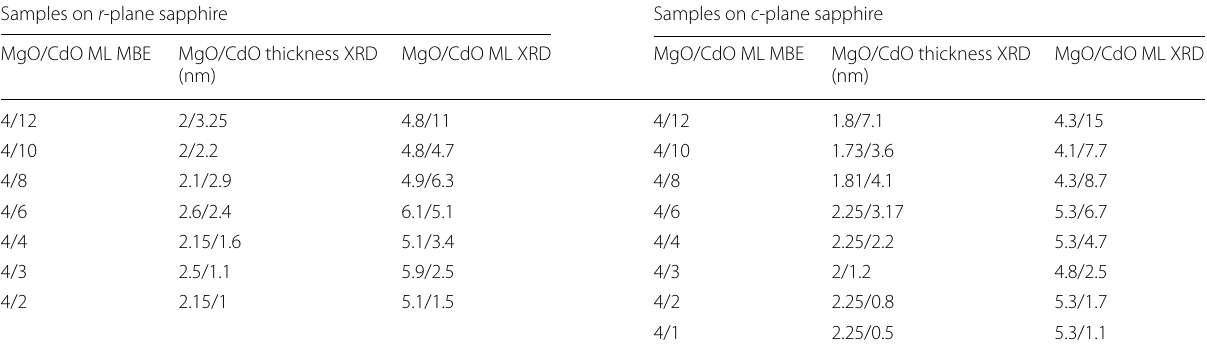
Table 1 Thicknesses of individual layers in {CdO/MgO} superlattices on r -sapphire and on c -sapphire planed in MBE growth process and the best fit of XRD calculations